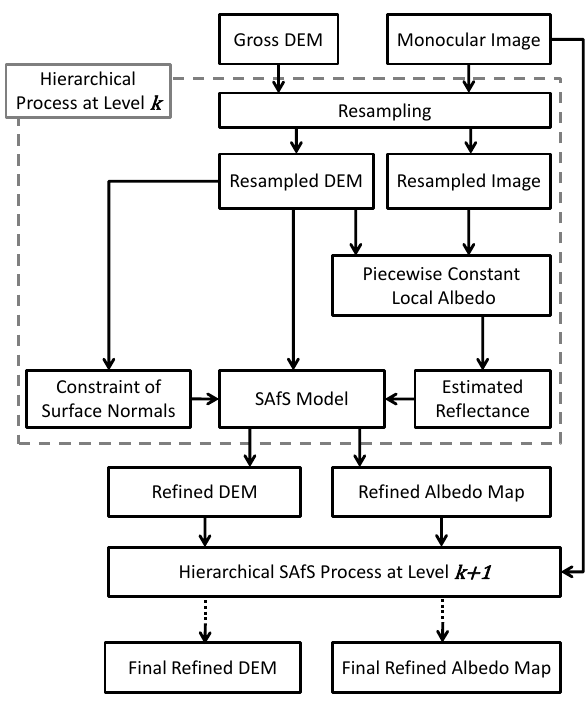
Figure 1. Framework of the SAfS algorithm